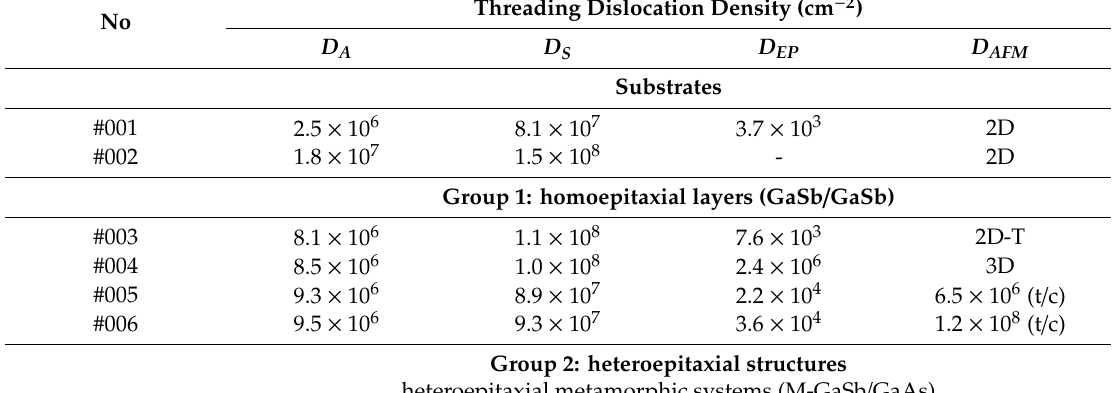
Table 3. The threading dislocation density for di ff erent structures using three methods: high-resolution x-ray di ff raction (HRXRD) ( D A and D S ), etch pit density (EPD) ( D EP ), and atomic force microscopy (AFM) ( D AFM